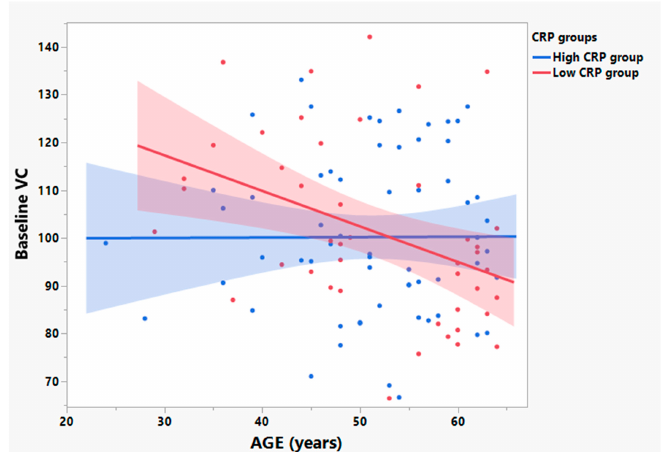
Figure 5. Baseline vital capacity (VC) values worsen with age in ALS patients with low baseline plasma CRP as compared to those with high plasma CRP in the participants age ≤ 65 years old. Bivariate linear fit was used for the linear regression analysis. In the participants aged ≤ 65 years old, baseline VC was negatively related to age in the low CRP group (R 2 = 0.16, p = 0.007, n = 44, depicted in red). However, no linear association between baseline VC and age was observed in the high CRP group (R 2 = 0.00, p = 0.98, n = 62, depicted in blue).